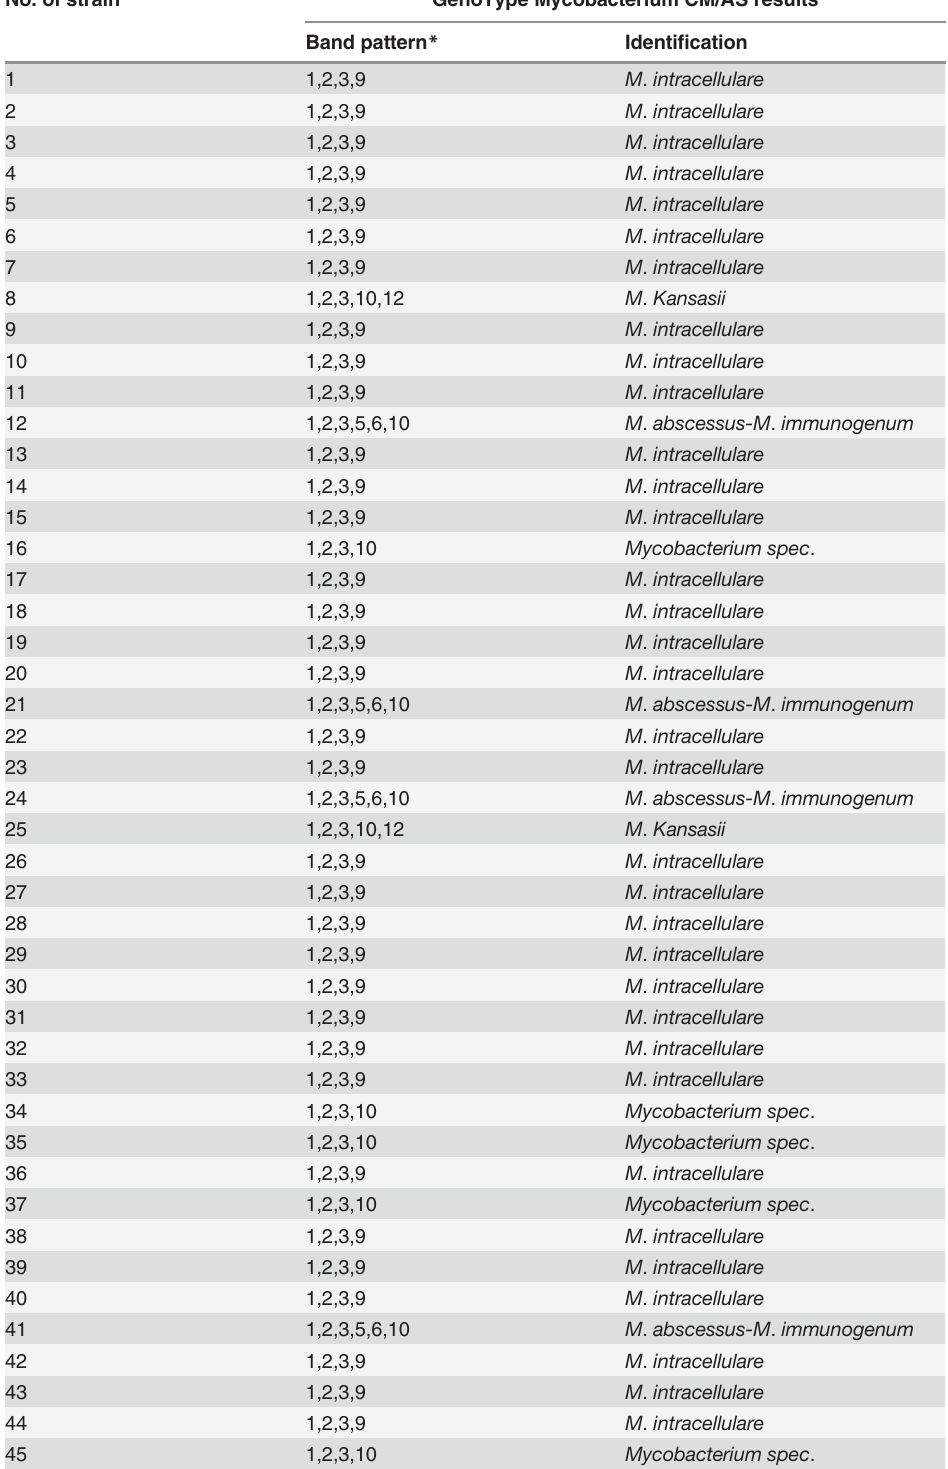
Table 1. Identi fi cation of mycobacteria by GenoType Mycobacterium CM/AS